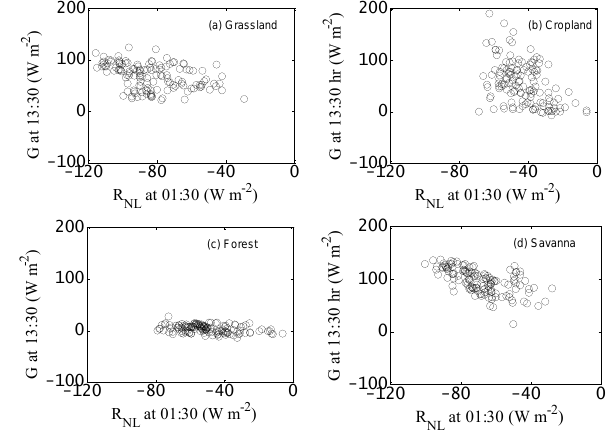
Figure 3. Examples of the diurnal evolution of net available energy ( (cid:56)) ( = λE + H ) during three different times of year over four rep- resentative biome types. This shows (cid:56) ∼= 0 around 01:30LT.